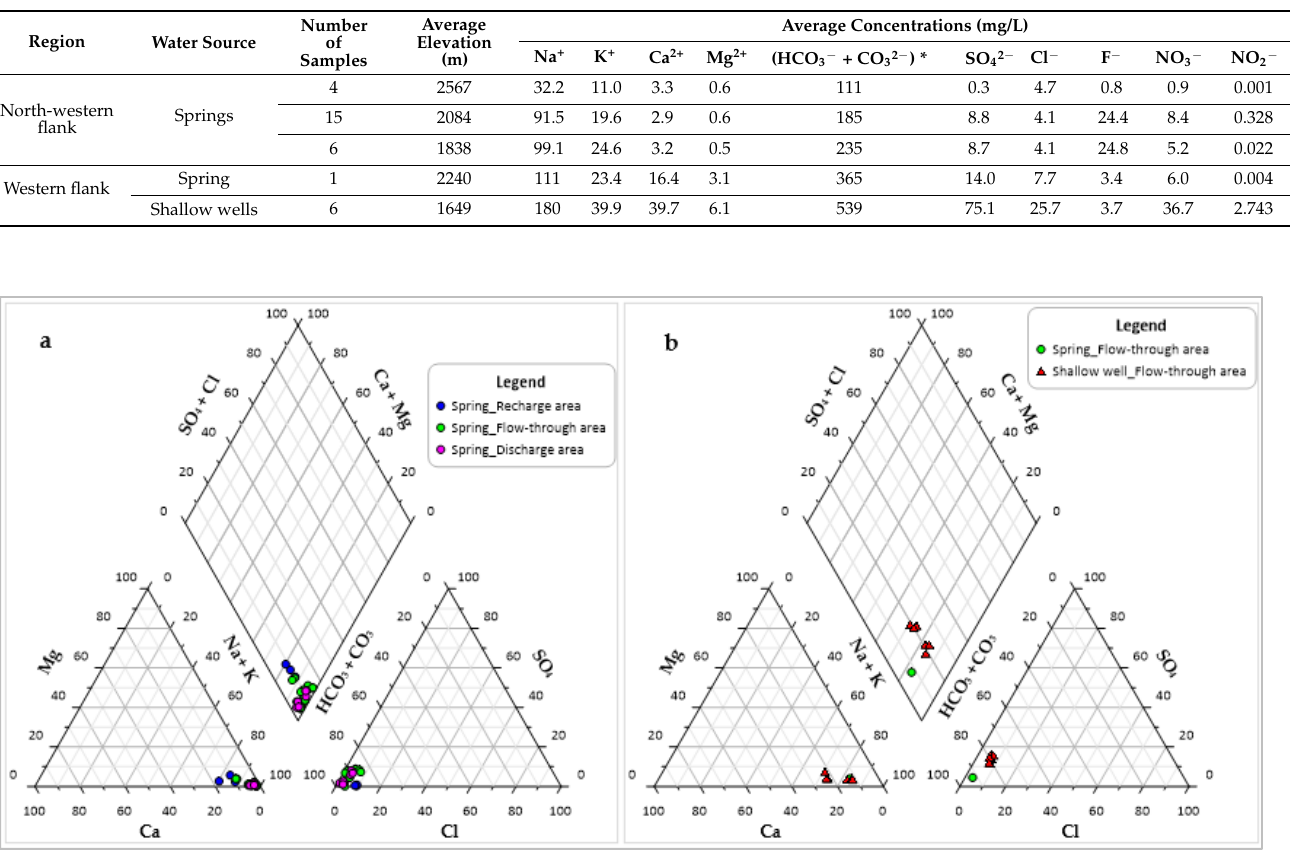
Table 6. Average values of major and minor ions in the water samples from different elevations on the northwestern and western flanks (* as mg/L HCO 3 ⁻ ).